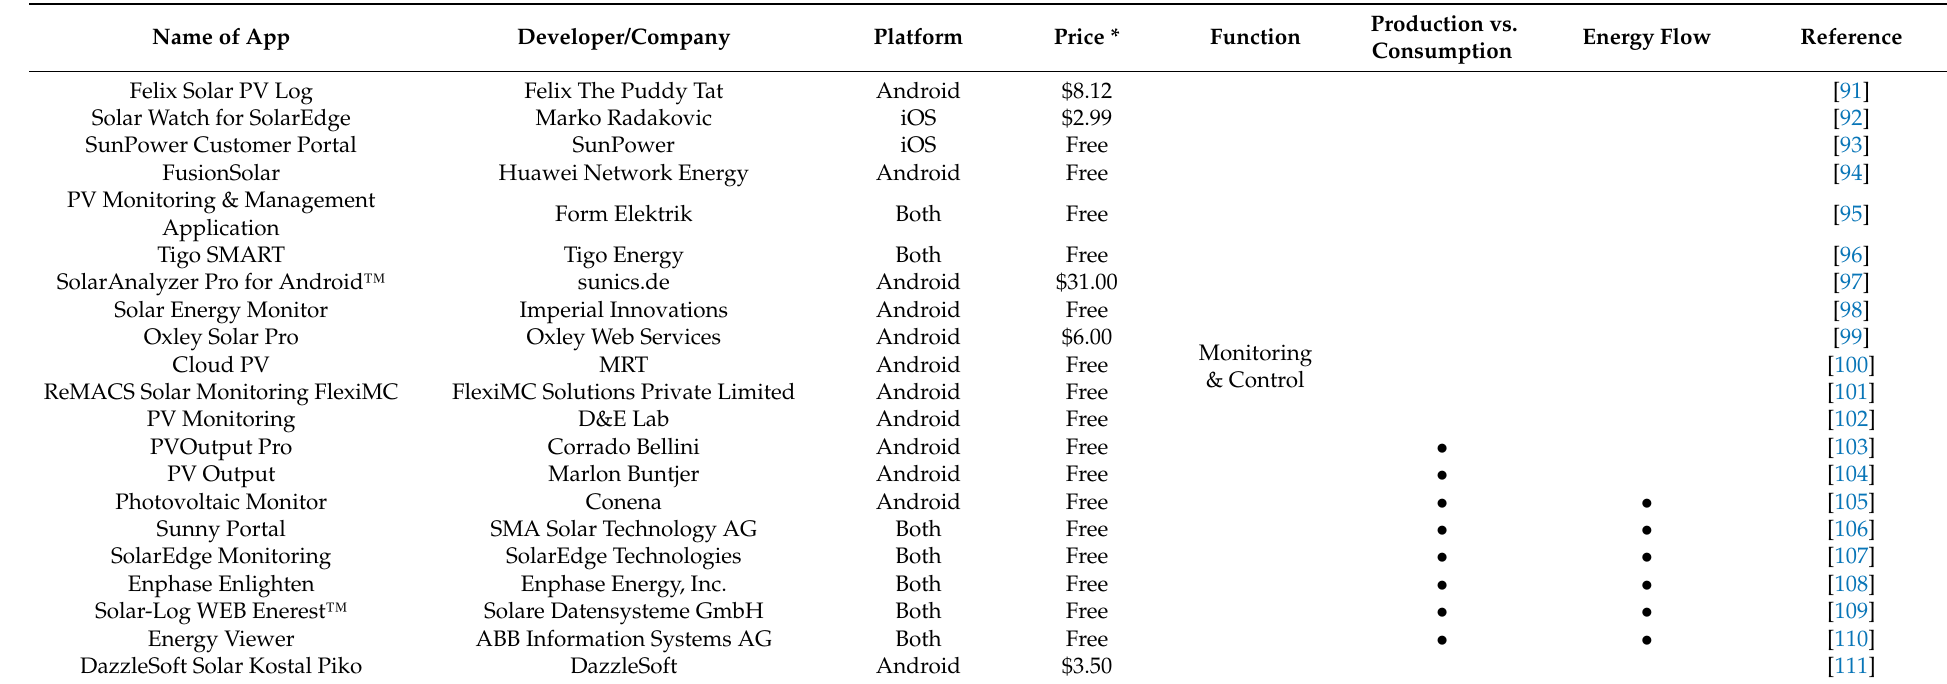
Table 8. Summary of smartphone applications on monitoring and control of PV